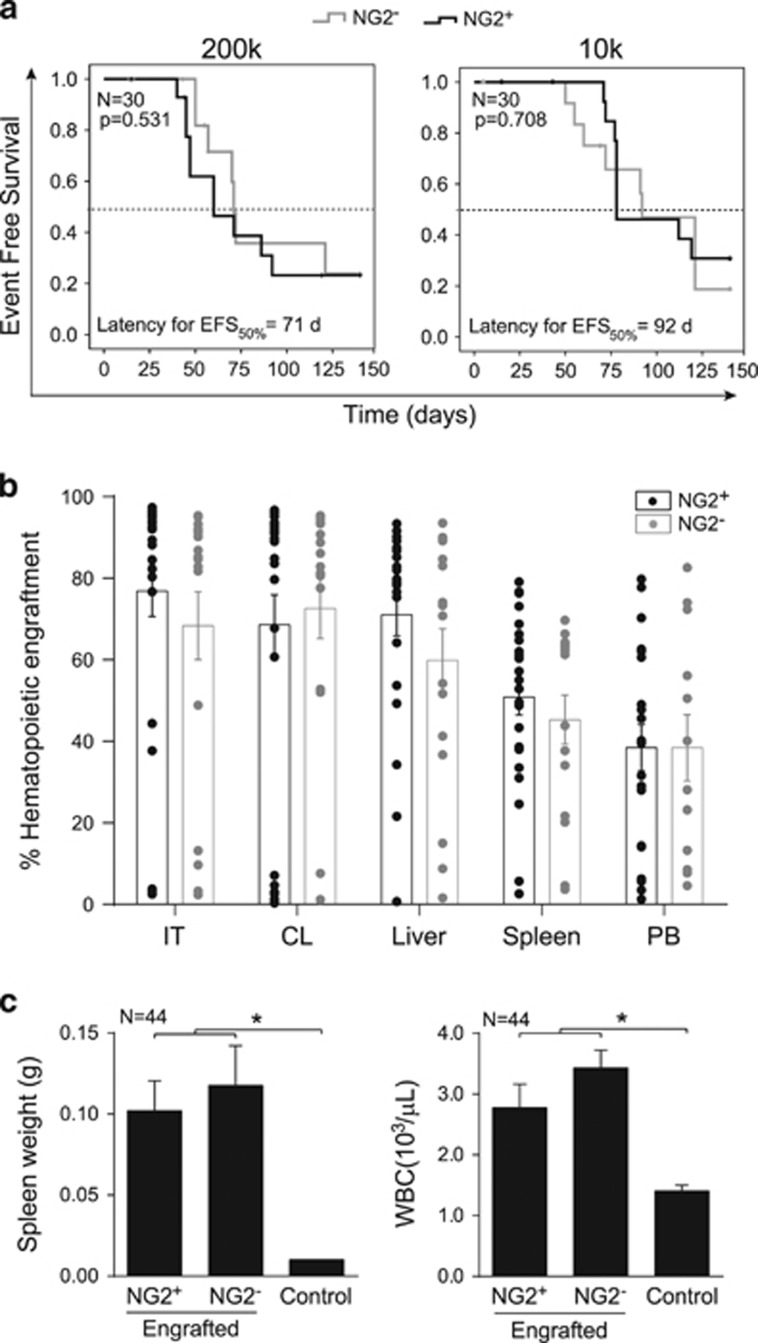
NG2 expression does not enrich for L-IC capacity in secondary recipients. (a) Kaplan–Meier survival curves for EFS according to different cell doses transplanted into secondary recipients (n=60). Black and gray lines represent secondary recipients transplanted with NG2+ and NG2− primary animals, respectively. Dotted line depicts EFS rate of 50%. (b) Percentage of long-term leukemic engraftment in the injected (IT) and contralateral (CL) tibia, liver, spleen and PB of secondary mice. (c) Secondary recipients of cells from either NG2+ or NG2− primary mice consistently displayed splenomegaly and high WBC counts.*P<0.05.